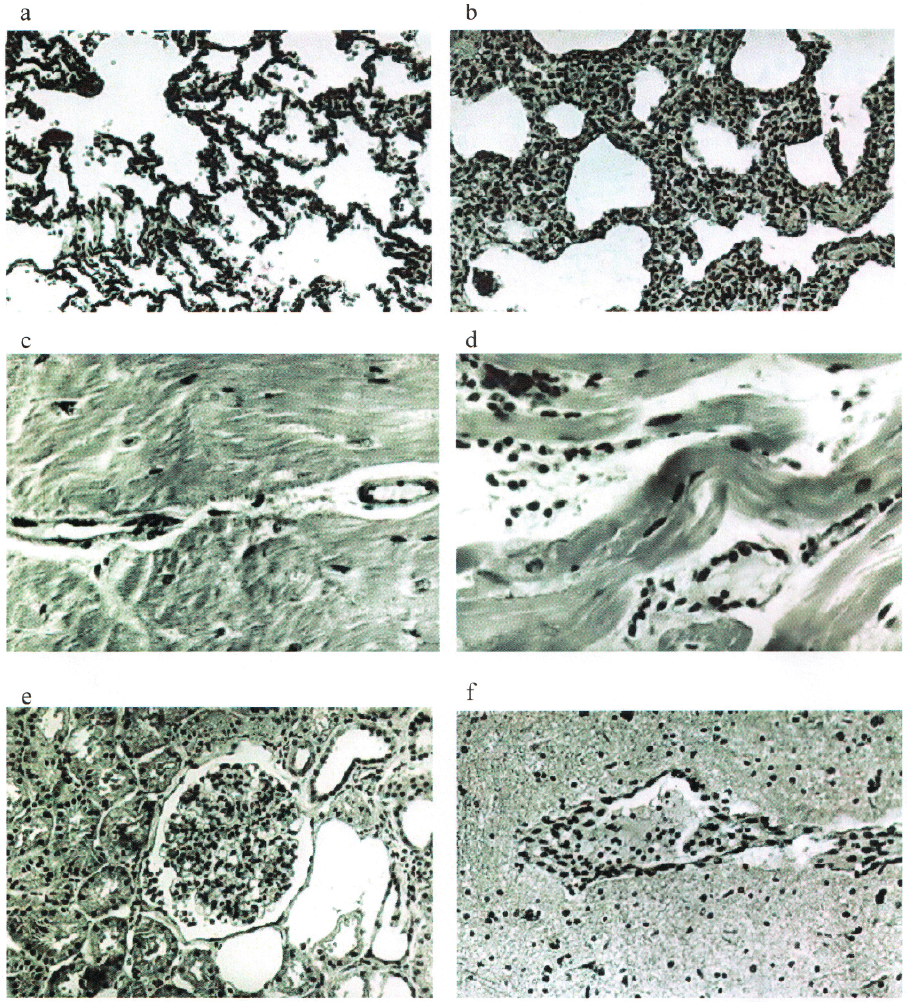
Fig. 3. light microscope, magnification: x 440, colouring: haematoxylin. Nuclei of leukocytes are spheric with dense colouring. The 4 th postoperative day. left pulmonary lobe: a) aphaeretic group: normal parenchyma, b) control group: resorbing edema, interalveolar leukocyte infiltration. left ventricle: c) aphaeretic group: normal parenchyma with the arteriolar cross section, d) control group: leukocyte endothelial arteriolar adhesion and leukocyte infiltration of the interfibrillar space. Kidney: e) control group: glomerular cross section with protein drops and leukocytes. Brain, frontal lobe: f) control group: leukocyte endothelial arteriolar adhesion and extensive leukocyte glial